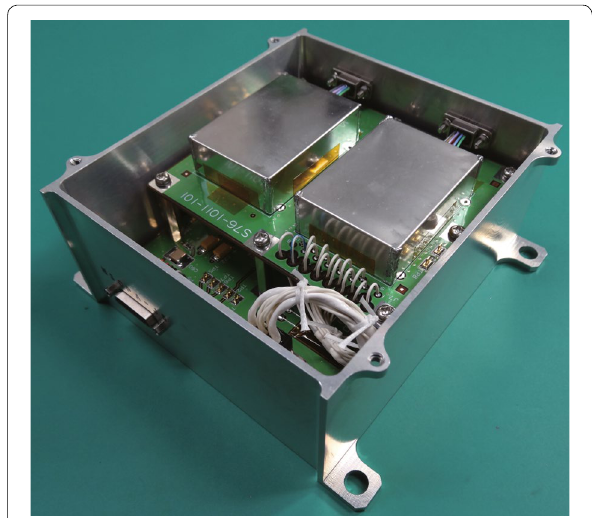
Fig. 6 Photograph of the MSC-PA. The size of chassis is 110 125 60 mm (protruding parts not × ×